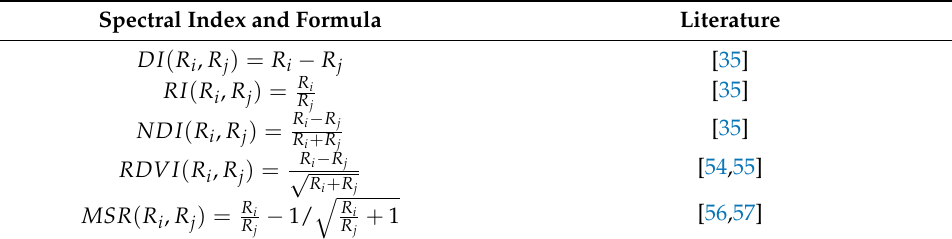
Table 1. A summary of the set of spectral indexes used in this study. Spectral Index and